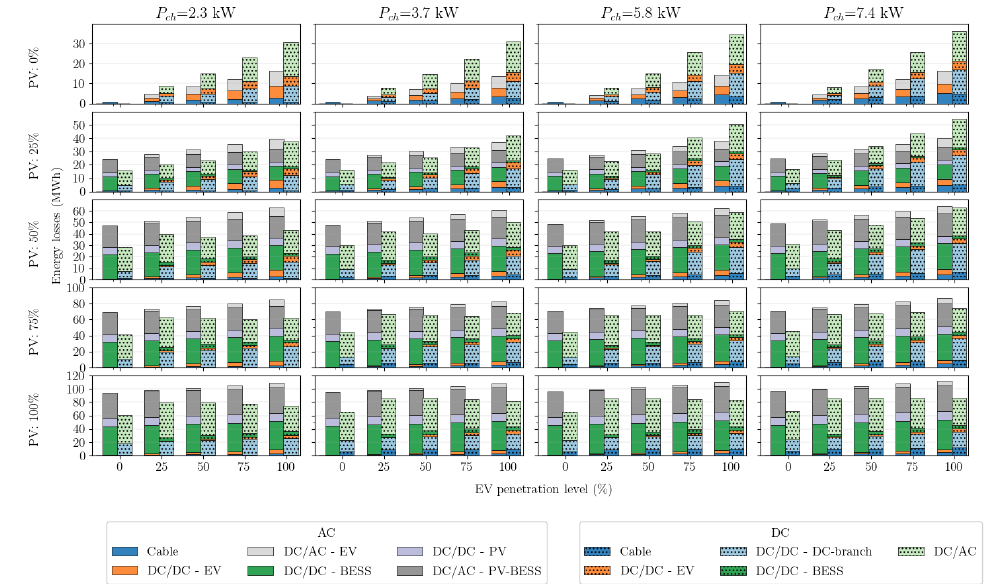
Figure 5. Conversion and cable losses for different EV charging powers and PV penetration levels for a conventional LVAC grid and the proposed LVDC